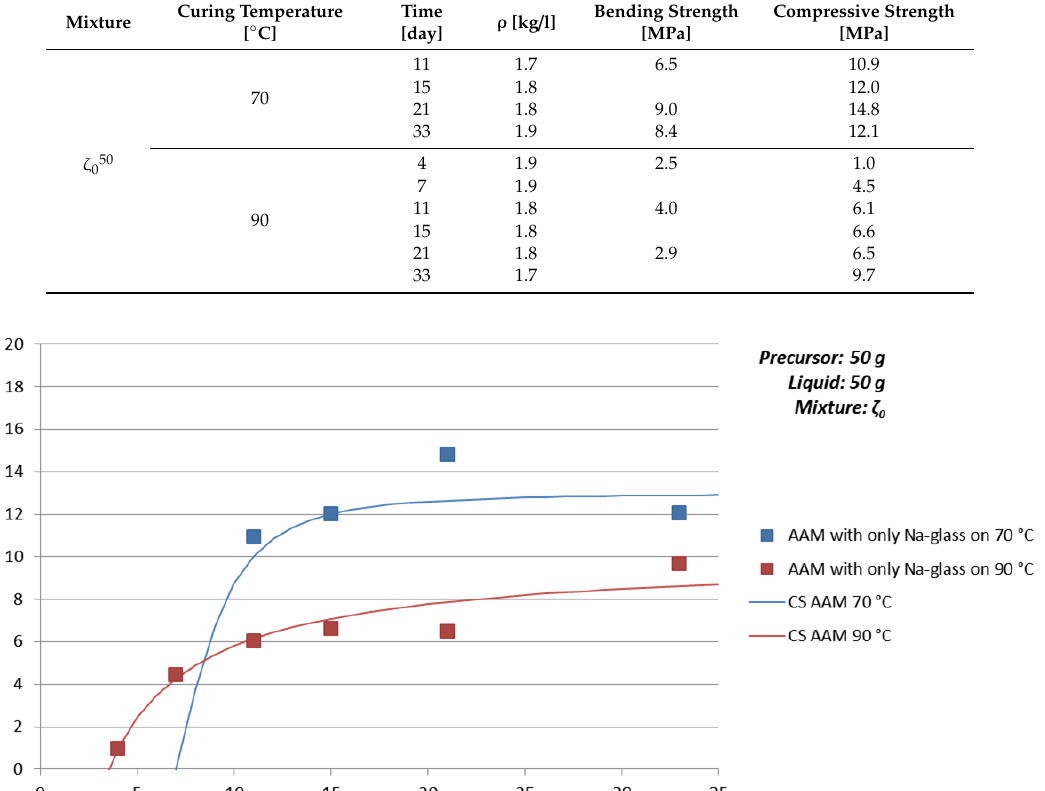
Table 9. Time dependence of density, bending, and compressive strength of AAM prepared with mixture ζ 0 , cured on 70 °C for seven days and cured on 90 °C for one day. Mixture